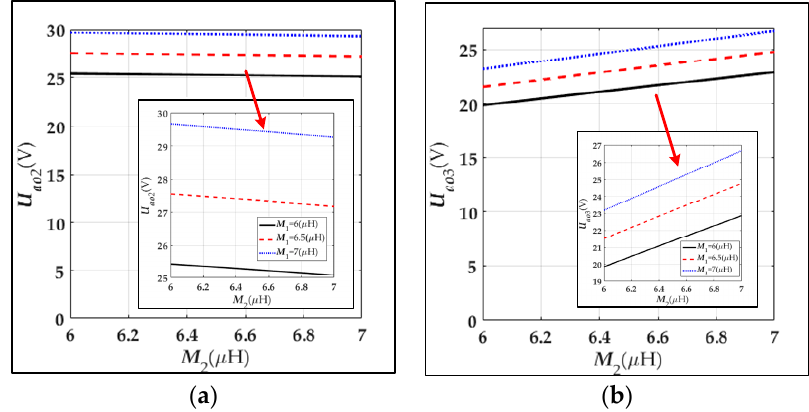
Figure 5. The variation of the output voltages with the mutual inductances in Mode A. ( a ) The variation of U ao 2 with M 1 and M 2 ; ( b ) the variation of U ao 3 with M 1 and M 2 .